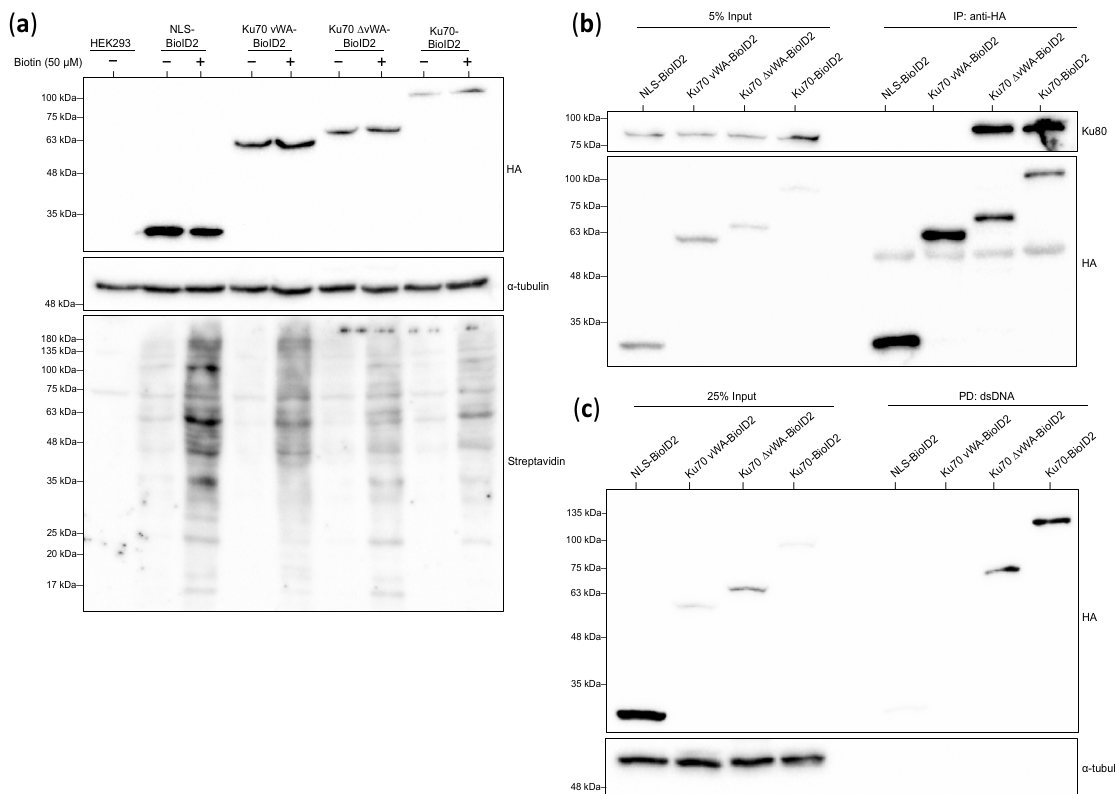
Figure 3. Preliminary experiments for Ku70-BioID2 constructs in HEK293 stable cell lines. Note that all constructs are HA-tagged at their C-terminus. Samples were visualized by Western blotting of 10% gels run by SDS-PAGE; ( a ) Testing biotinylation capability. Cell lines were incubated with or without 50 μ M biotin for 24 h. Cells were lysed for whole cell protein extracts (WCE). Blots were probed with HRP-streptavidin; ( b ) Testing for Ku80 interaction. Co-immunoprecipitation conducted with 1 mg WCE; ( c ) Testing for DNA association. Double-stranded DNA pulldown conducted with 100 μ g nuclear protein extracts.